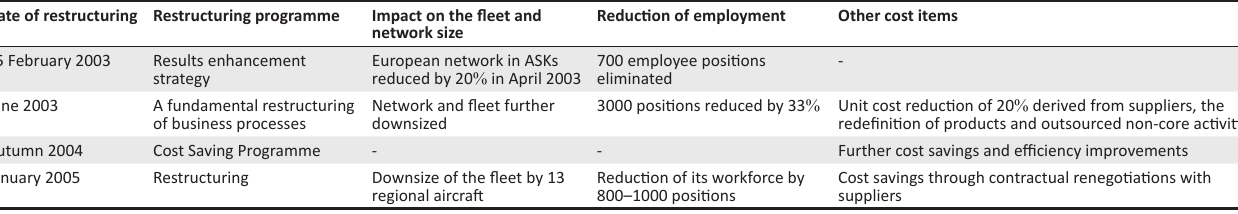
TABLE 11: Components of SWISS restructuring